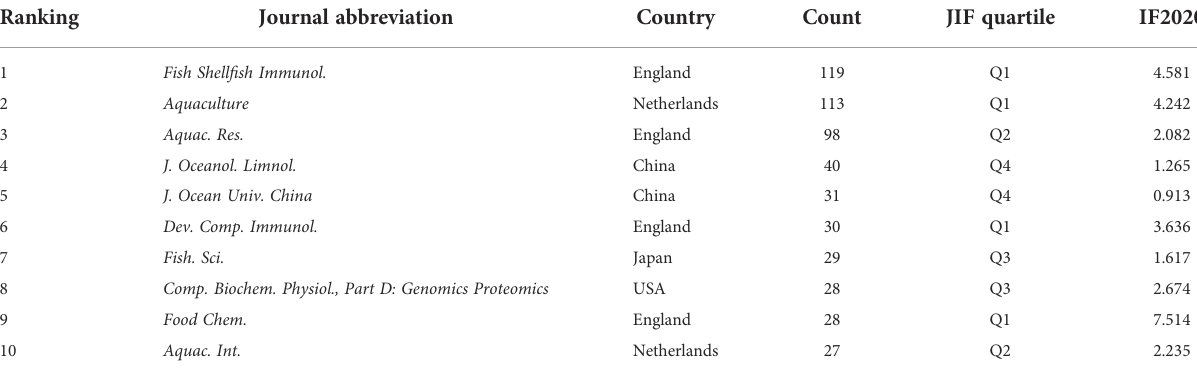
TABLE 3 The most active journals with publication volume on Apostichopus japonicus search from 2000 to 2021. Ranking